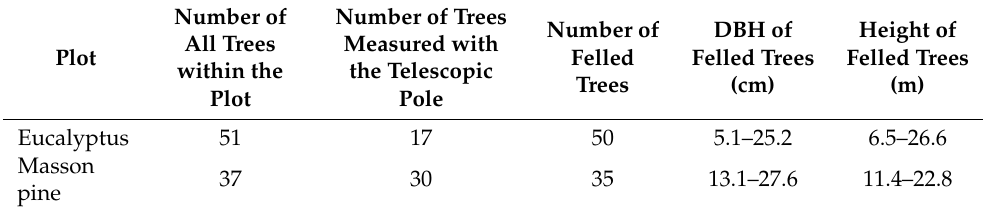
Table 1. Plot characteristics of eucalyptus and Masson pine.